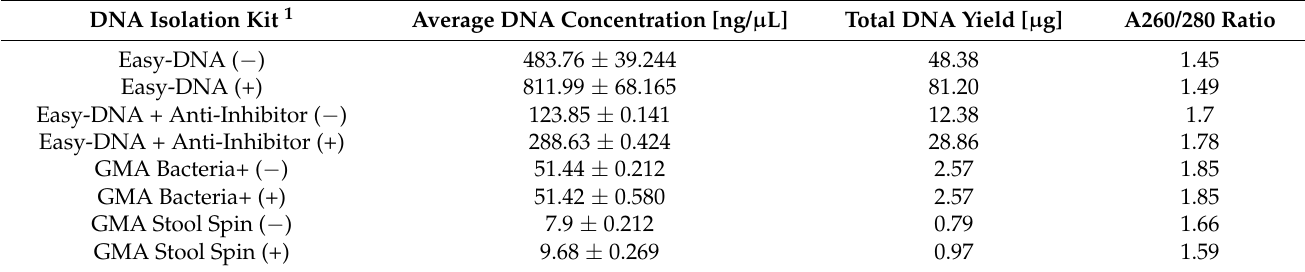
Table 3. The results of DNA isolation for sample B7.